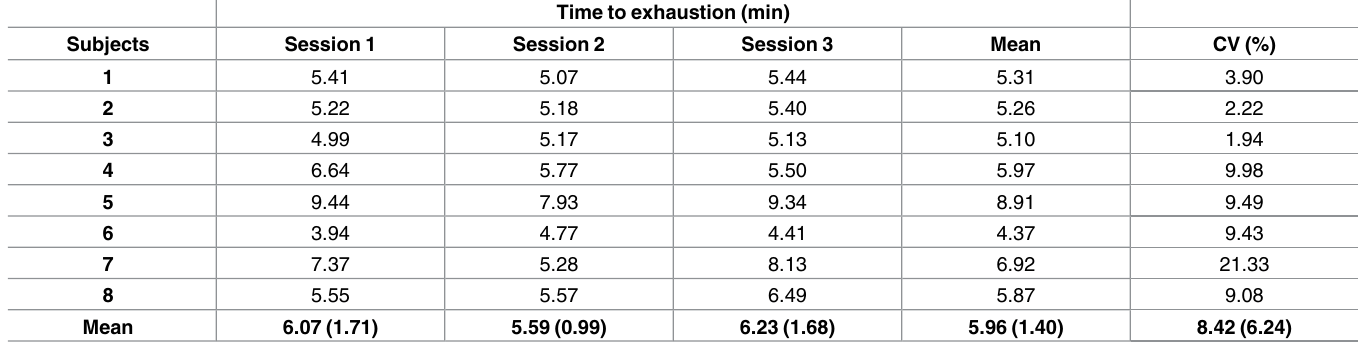
Table 2. High intensity one-leg dynamic exercise(85% peak power output) time to exhaustion and coefficient of variation (CV). One-way repeated ANOVA revealed no difference between sessions (p = 0.156). Mean (SD) and individualdata are